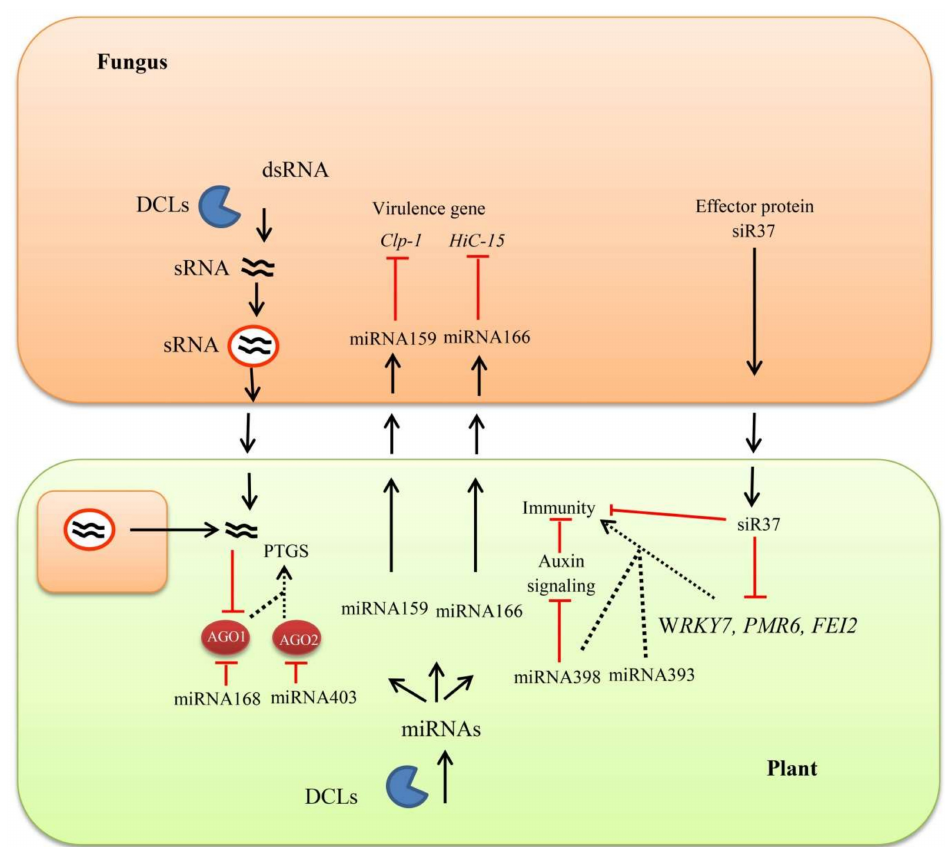
Figure 3. Role of RNAi in plant–fungal pathogen interaction. Plants activate biogenesis of various small RNAs or microRNAs (miRNAs) that enhance or inhibit certain signaling relating to the resistance or susceptibility against fungal pathogens. Some miRNAs are delivered to pathogens through cross-kingdom RNAi to perform silencing or inhibit virulence related genes of the interacting pathogens. The fungal pathogens also deliver certain effector proteins that hijack the RNAi components or suppress host defense related genes. Posttranscriptional gene silencing (PTGs), isotrichodermin C-15 hydroxylase (HiC-15), and Ca2 + -dependent cysteine protease